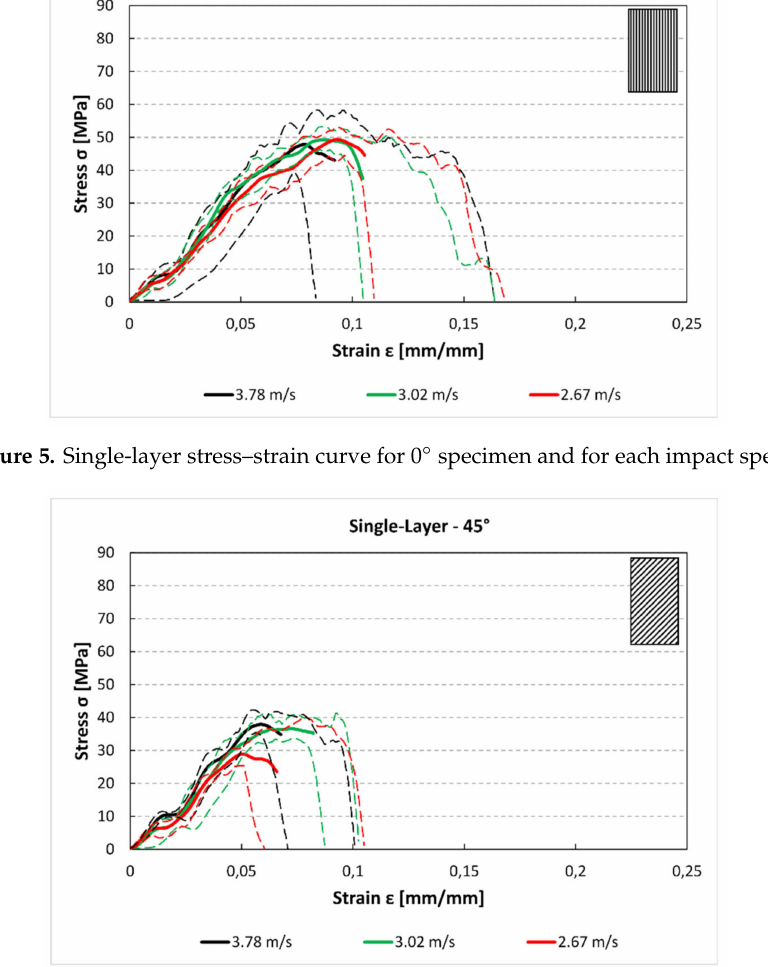
Figure 6. Single-layer stress–strain curve for 45 ◦ specimen and for each impact